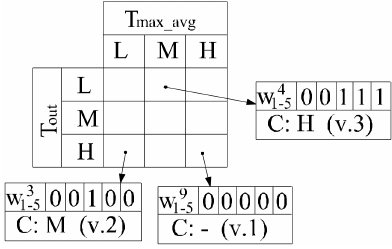
Figure 3. Consequents combining